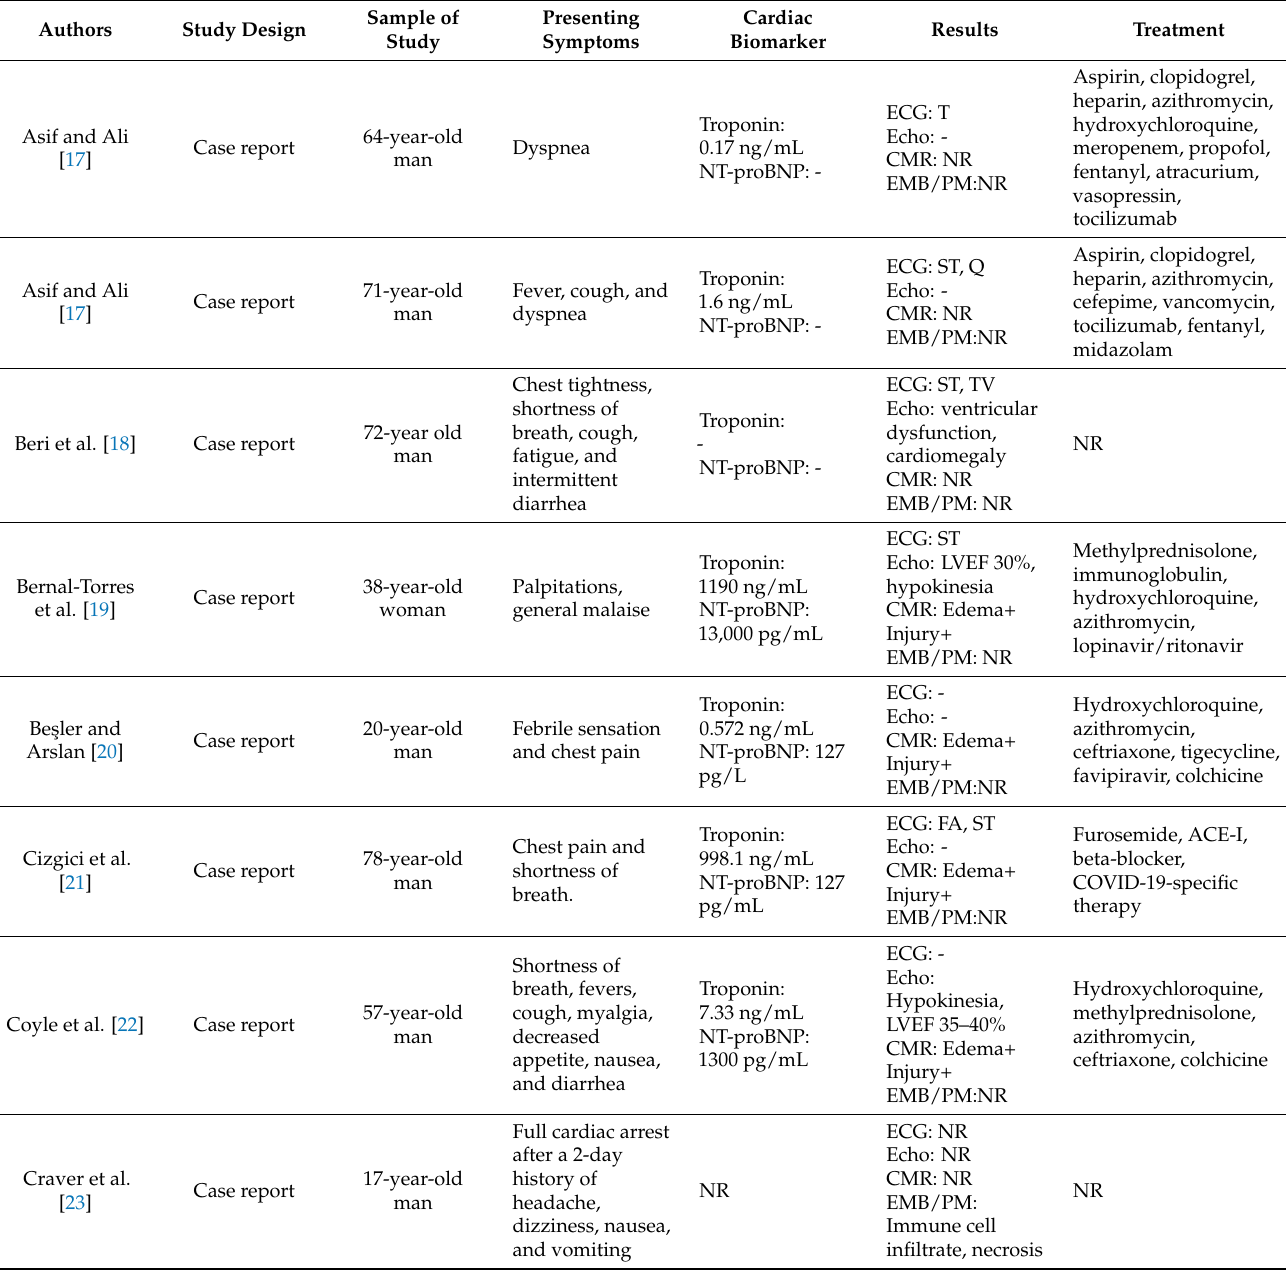
Table 1. Characteristics of published cases of SARS-CoV-2-induced